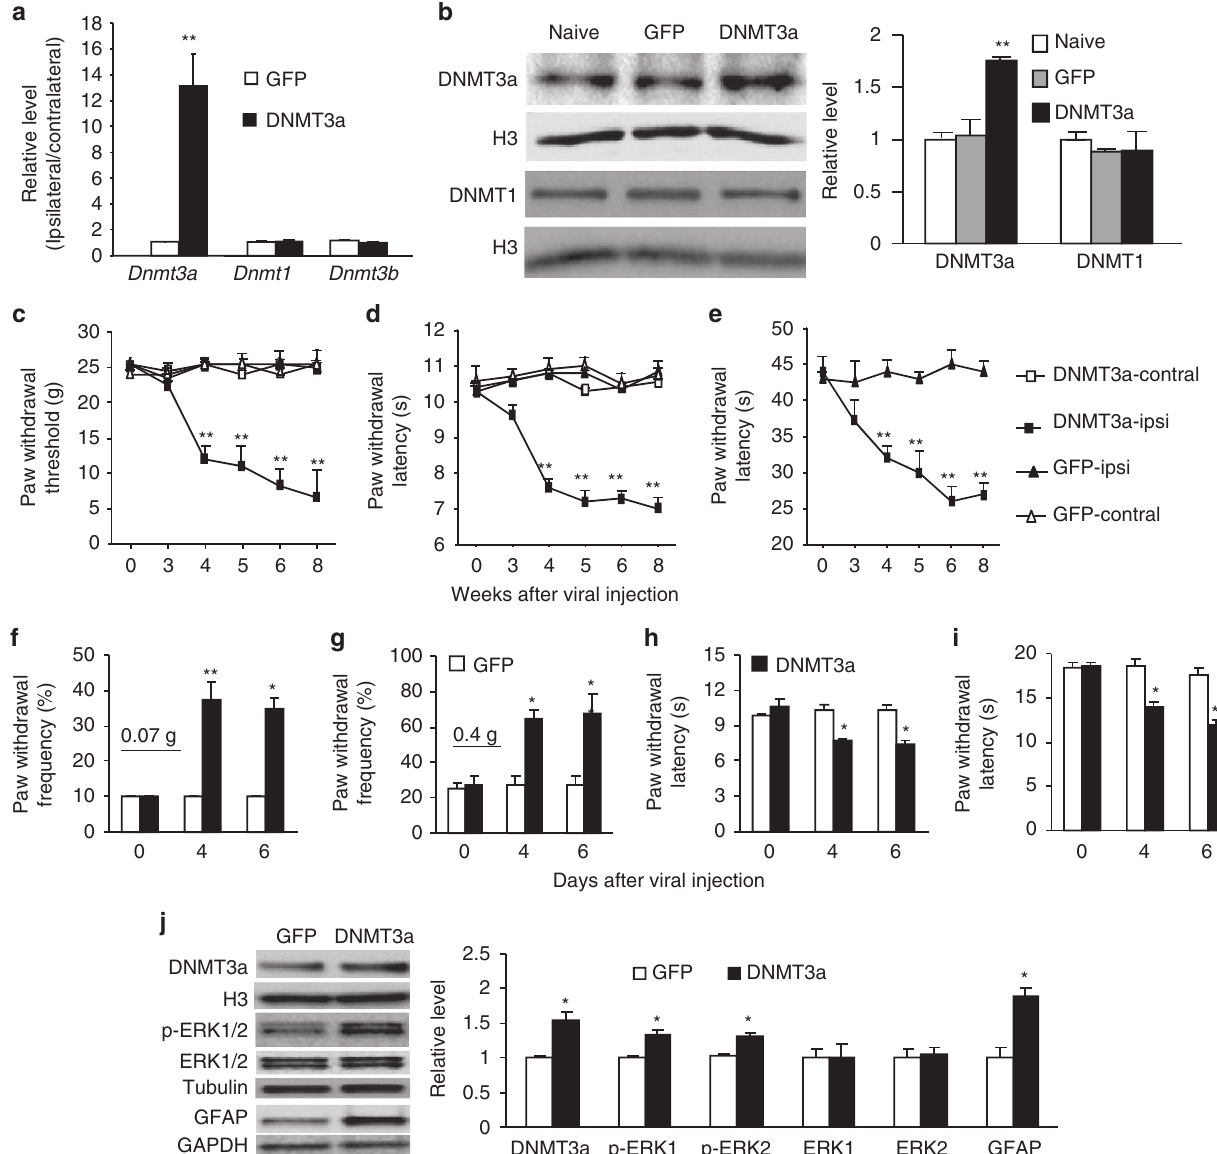
Figure 6 | DRG Dnmt3a overexpression produces neuropathic pain symptoms in both rats and mice. GFP: AAV5- GFP in a – e or HSV- GFP in f – j . DNMT3a: AAV5- Dnmt3a in a – e or HSV- Dnmt3a in f – j . ( a ) Amounts of Dnmt3a, Dnmt1, and Dnmt3b mRNAs in the ipsilateral and contralateral L4/5 DRG 8 weeks after viral microinjection into the ipsilateral L4/5 DRG in rats. n ¼ 3 rats per group. ** P o 0.01 versus the corresponding GFP group by two-tailed unpaired Student’s t -test. ( b ) Levels of DNMT3a and DNMT1 proteins in the ipsilateral L4/5 DRG in naive rats and 8 weeks after viral microinjection into the ipsilateral L4/5 DRG in rats. n ¼ 3 rats/group. One-way ANOVA followed by post hoc Tukey test, F group (2, 8) ¼ 40.7 for DNMT3a and F group (2, 8) ¼ 1.21 for DNMT1. ** P o 0.01 versus naive rats. Full-length blots are presented in Supplementary Fig. 6. ( c – e ) Paw withdrawal responses to mechanical ( c ), thermal ( d ) and cold ( e ) stimuli on the ipsilateral (ipsi) and contralateral (contral) sides at time points as shown after viral microinjection into the ipsilateral L4/5 DRG in rats. n ¼ 10 rats per group. Two-way ANOVA followed by post hoc Tukey test, F group (3, 119) ¼ 206.9 for ( c ), F group (3, 119) ¼ 69.1 for ( d ), and F group (1, 59) ¼ 178.0 for ( e ). ** P o 0.01 versus the corresponding GFP group on the ipsilateral side. ( f – i ) Ipsilateral paw withdrawal responses to mechanical ( f , g ), thermal ( h ) and cold ( i ) stimuli at time points as shown after viral microinjection into the ipsilateral L3/4 DRG in mice. n ¼ 10 mice per group. Two-way ANOVA followed by post hoc Tukey test, F group (1, 23) ¼ 88.2 for ( f ), F group (1, 23) ¼ 28.4 for ( g ), F group (1, 23) ¼ 25.2 for ( h ) and F group (1, 23) ¼ 37.8 for ( i ). * P o 0.05 or ** P o 0.01 versus the corresponding GFP group. ( j ) Levels of DNMT3a, p-ERK1/2, ERK1/2 and GFAP in the ipsilateral L3/4 dorsal horn 6 days after viral microinjection into the ipsilateral L3/4 DRG in mice. n ¼ 12 mice per group. * P o 0.05 versus the corresponding HSV- GFP group by two-tailed unpaired Student’s t -test. Full-length blots are presented in Supplementary Fig. 6.